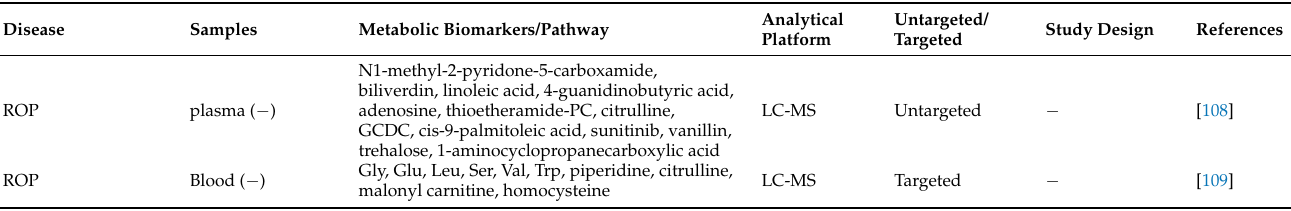
Table 3. Summary of metabolomics in retinopathy of prematurity